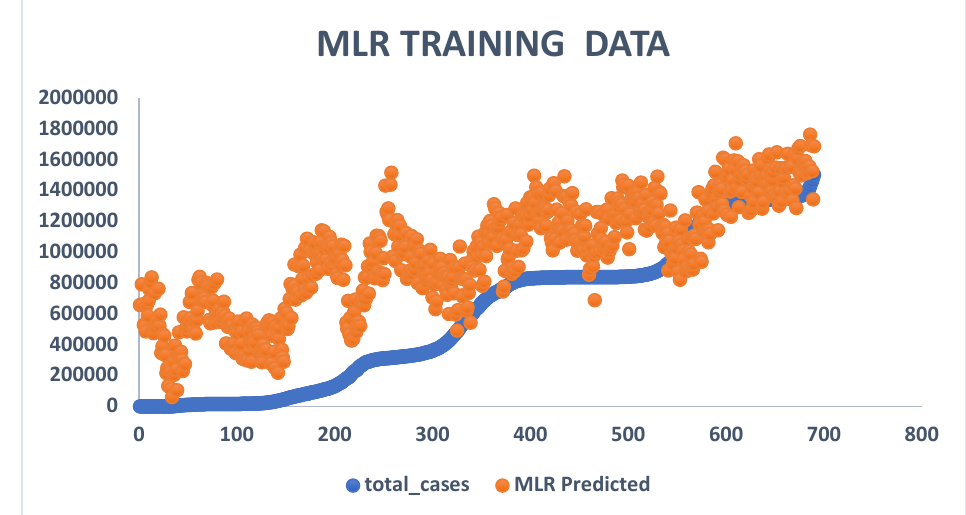
Figure 6. Vaccination influence on COVID-19 mortality cases in Israel.